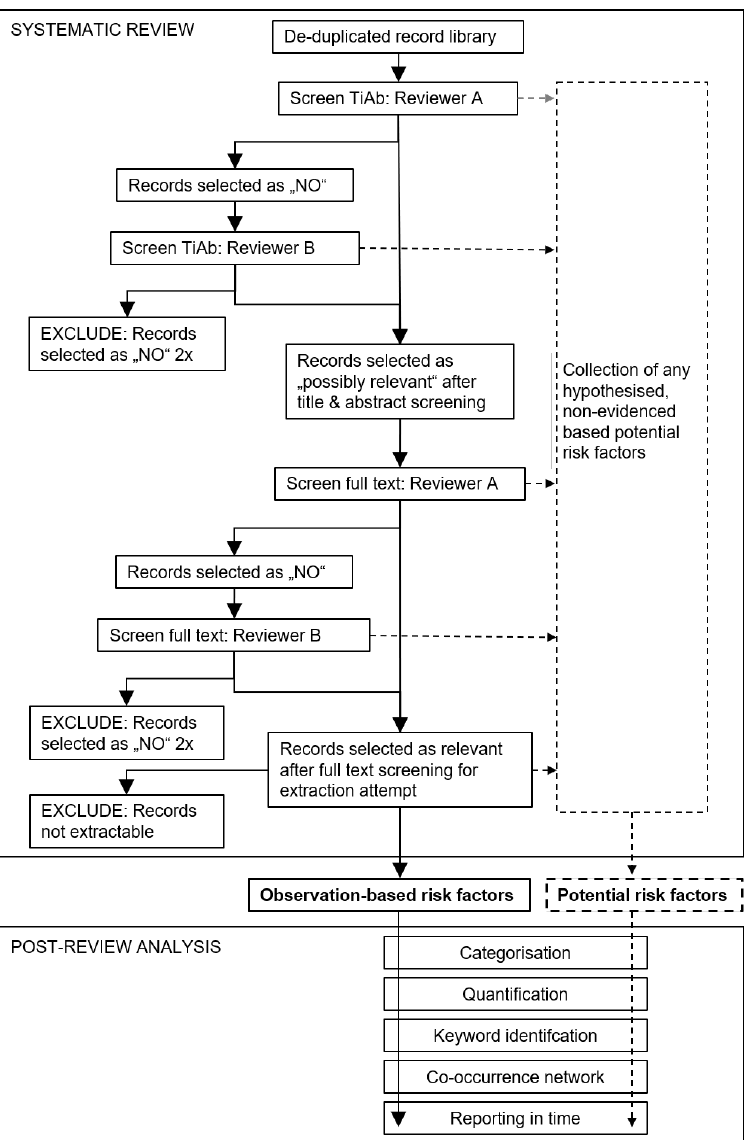
Figure 1. Schematic flow diagram of the literature screening procedure and post-analysis applied to de-duplicated African swine fever search libraries. If a record was deemed ineligible for the review questions, it was assessed again by a second independent reviewer for possible inclusion. Risk factors identified by systematic review were further examined in a post-review analysis. TiAb, title and